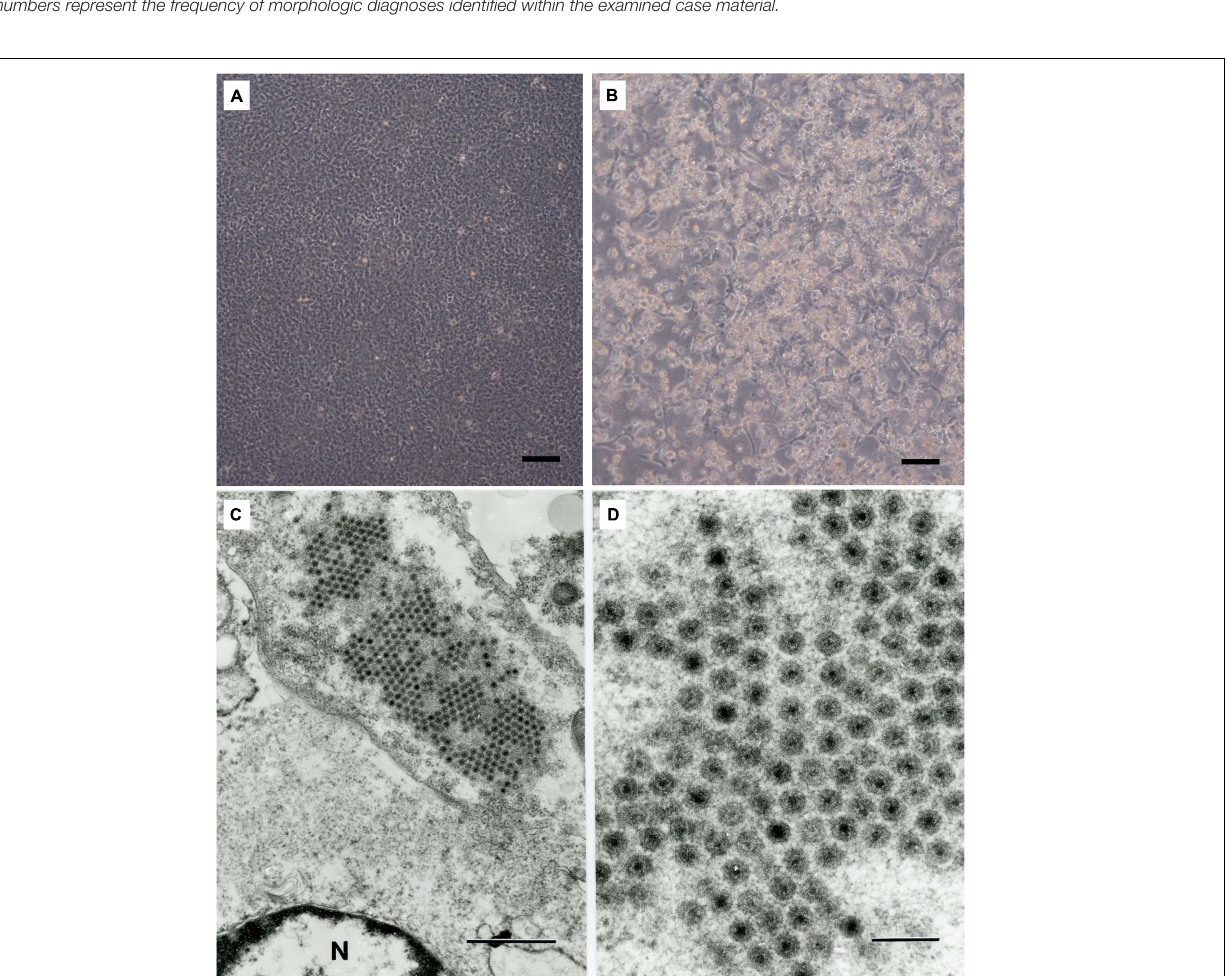
Hepatitis 0 The numbers represent the frequency of morphologic diagnoses identified within the examined case material.